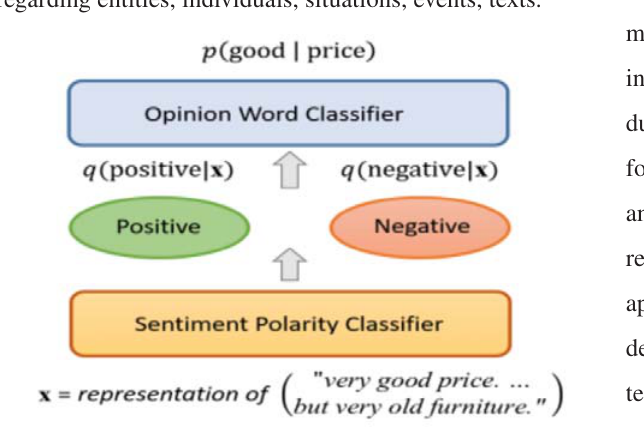
Fig. 1. Research carried out on sentiment